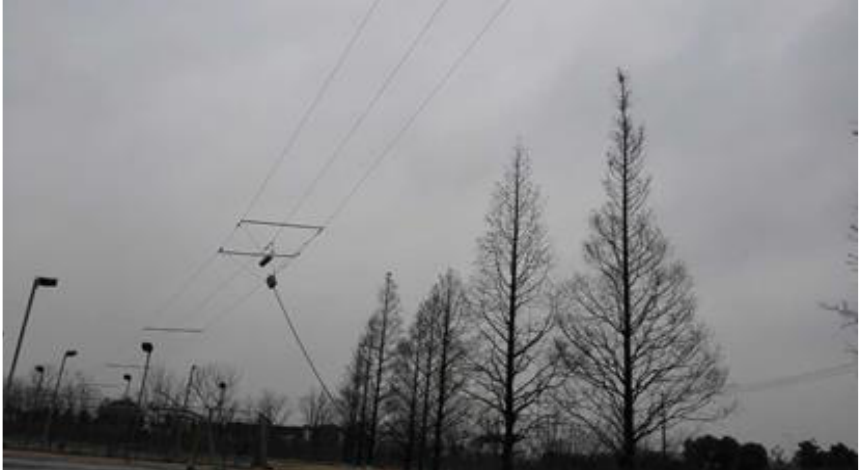
Figure 8. Erection image of 75 m three-wire transmitting antenna. It is a linear polarized dipole with the feed point in the center. Table 3. The variation of the transmitting antenna characteristics with the erection height.